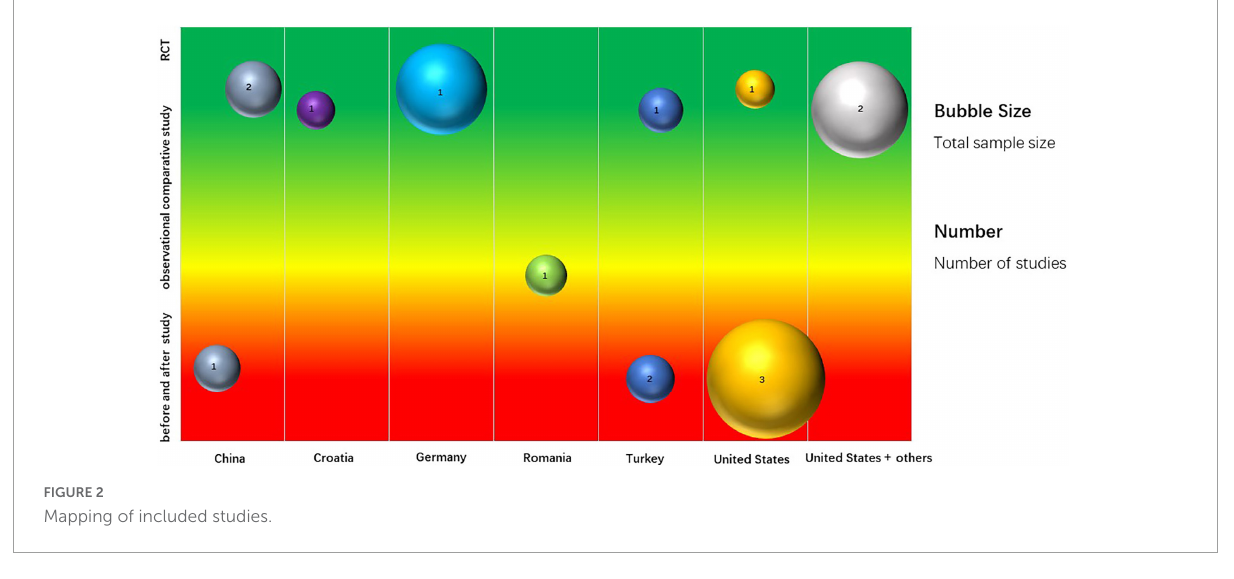
FIGURE2 Mapping of included studies.